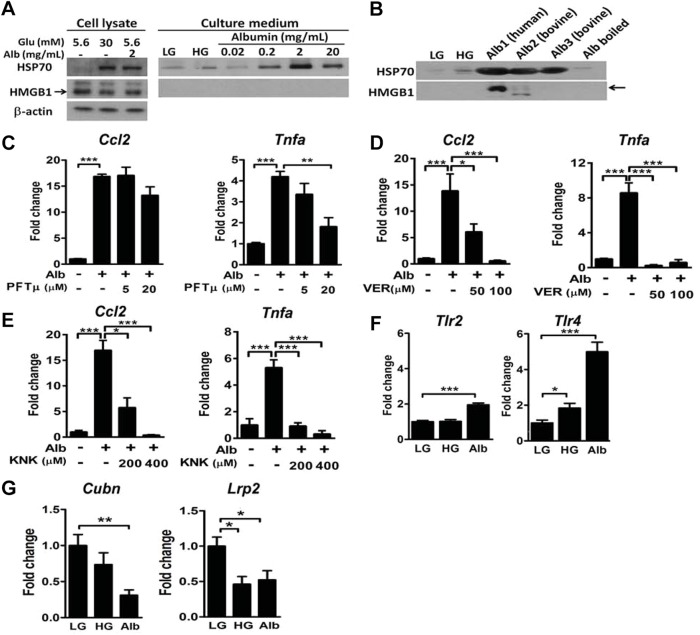
Effects of HG and albumin on DAMP release and gene expression in mPTCs. (A) Immunoblot analyses of HSP70 and HMGB1 from the cell lysate and culture medium of mPTCs treated with LG, HG and different concentrations of albumin for 24 h. (B) Immunoblot analyses of HSP70 and HMGB1 from the culture medium of mPTCs treated with various sources of albumin (2 mg/ml) as described for Fig. 3D. Expression of Ccl2 and Tnfα in WT mPTCs pretreated with pifithrin-μ (C), VER-155008 (D) and KNK437 (E) for 30 min before albumin stimulation. n=3-4 in each group. Expression of Tlr2 and Tlr4 (F) and Cubn and Lrp2 (G) in WT mPTCs treated with LG, HG and albumin (0.2 mg/ml) for 24 h. *P<0.05, **P<0.01 and ***P<0.001 by one-way ANOVA followed by Dunnett's test.